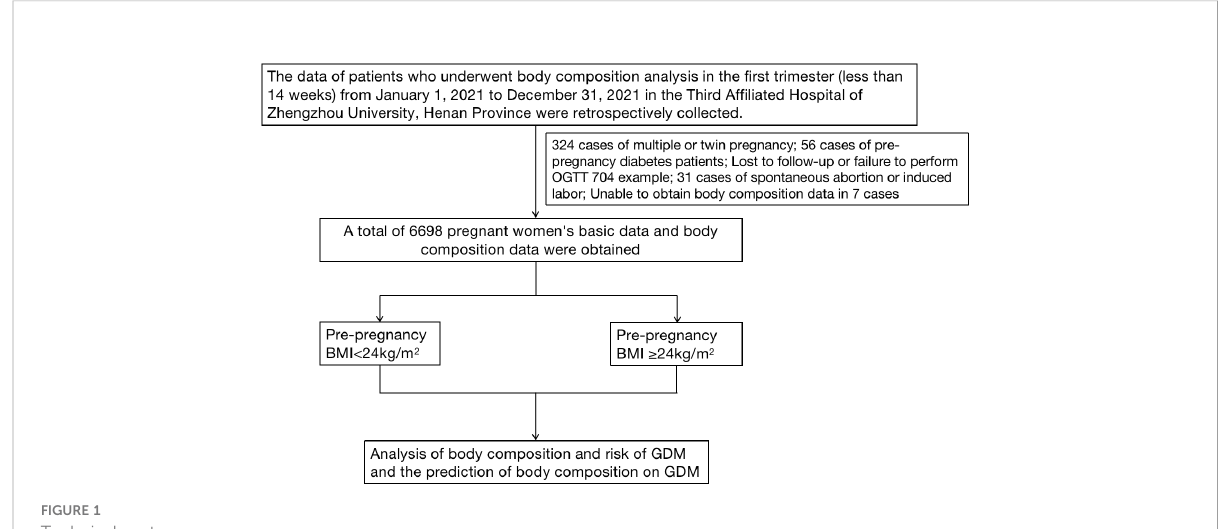
FIGURE 1 Technical